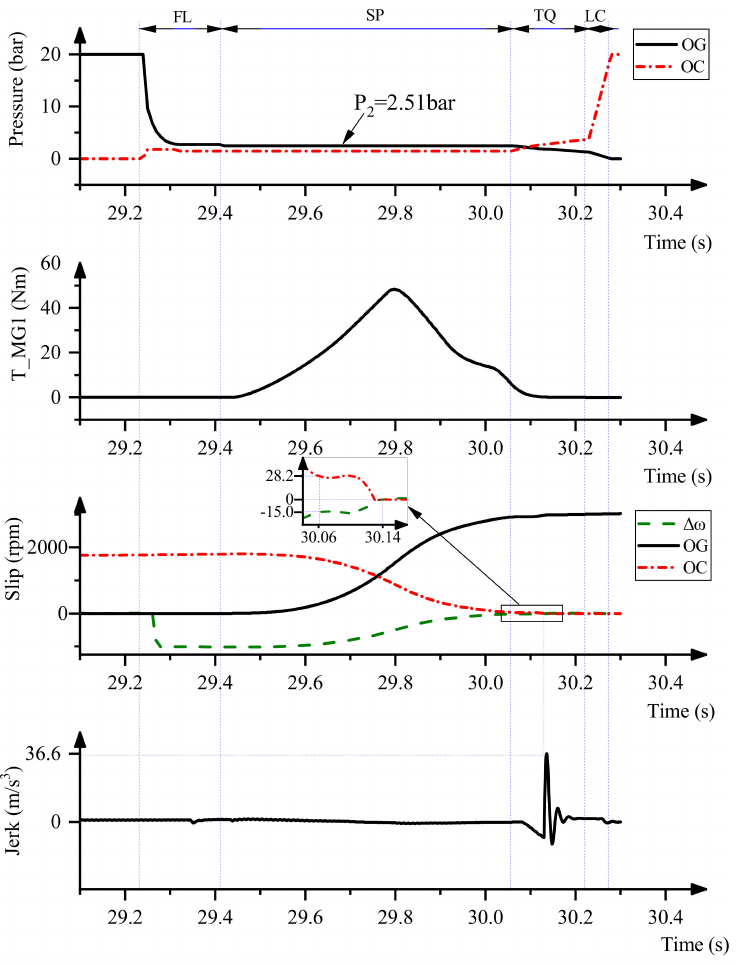
Figure 8. Simulation results of the shifting process ( P 2 = 2.51